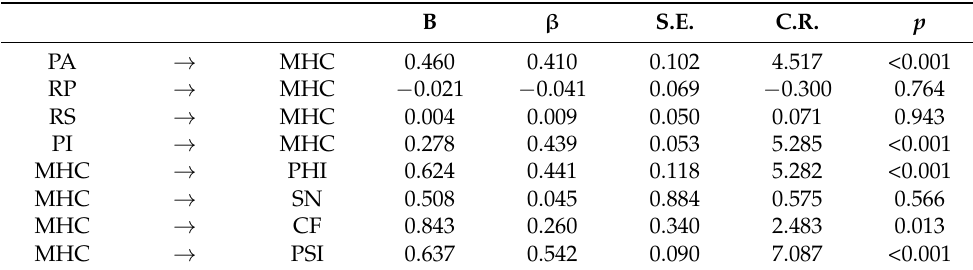
Table 5. Regression weights in the final research